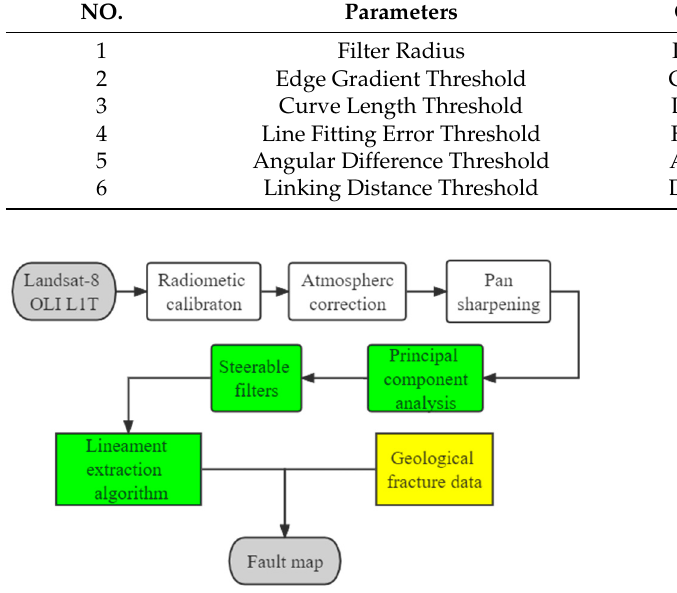
Figure 2. Methodology flowchart of lineaments extraction.